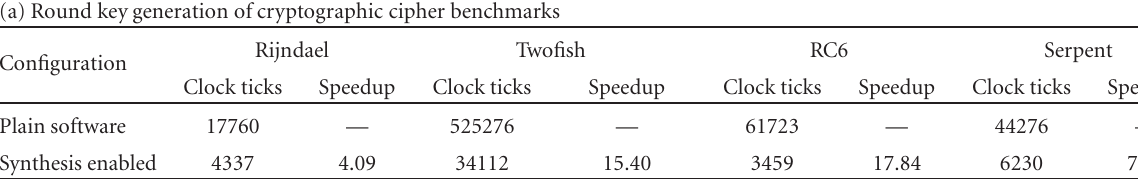
Table 1: Runtime acceleration of benchmark